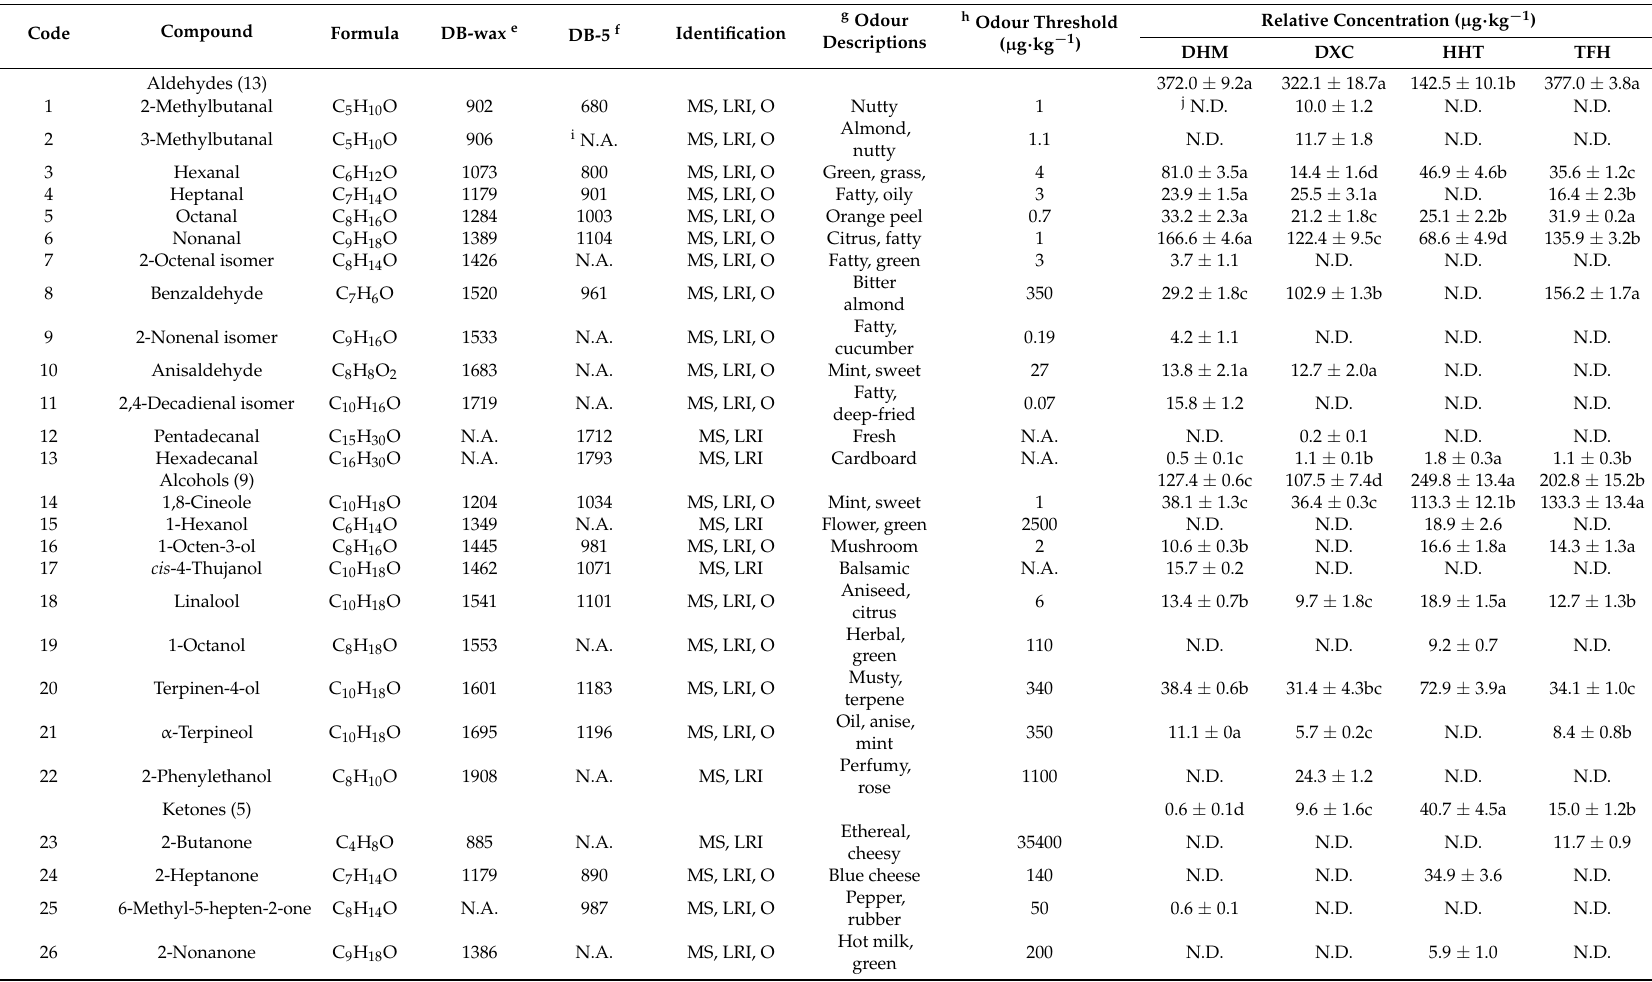
Table 1. Odour descriptions, odour thresholds and relative concentrations of volatile compounds in marinated pork hocks by